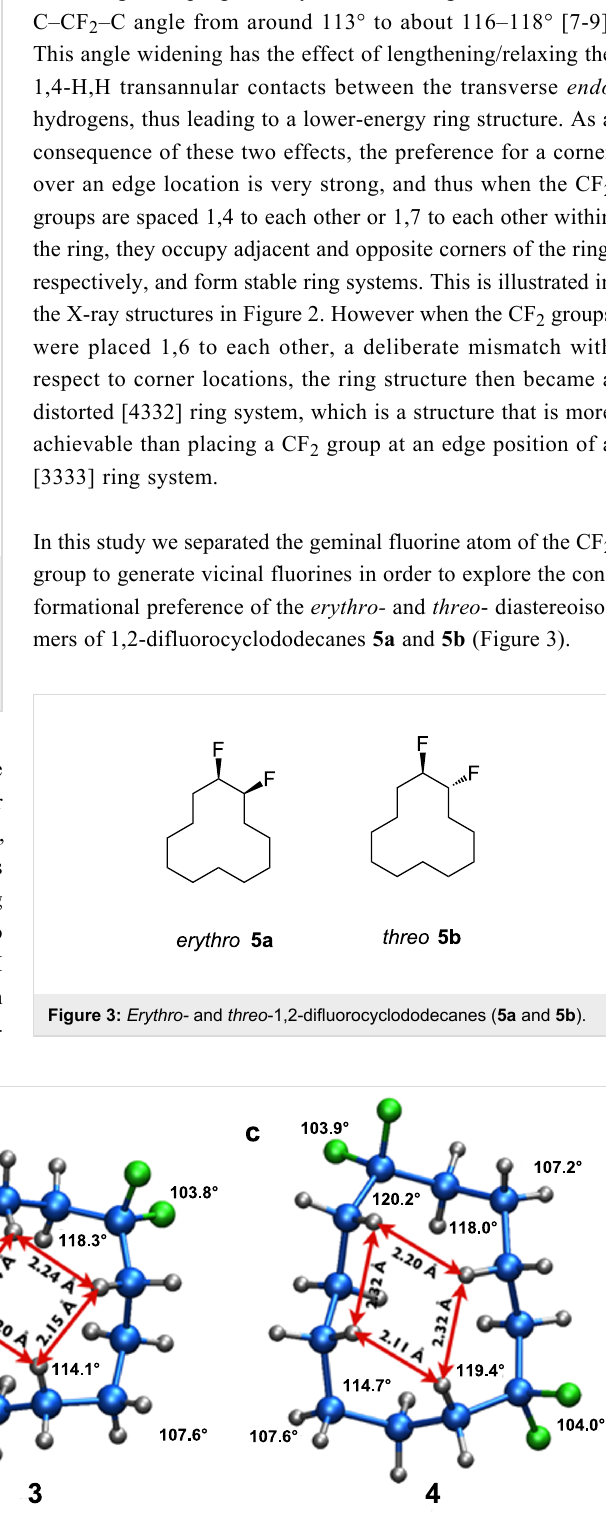
Figure 2: Crystal structures of (a) 1,1,4,4- (b) 1,1,7,7- and (c) 1,1,6,6-tetrafluorocyclododecanes ( 2 – 4 ) , illustrating the corner preference of the CF 2 groups. Structures 2 and 3 adopt a [3333] conformation, whereas 4 adopts a distorted [4332] conformation. Fluorine atoms are presented in green [7].